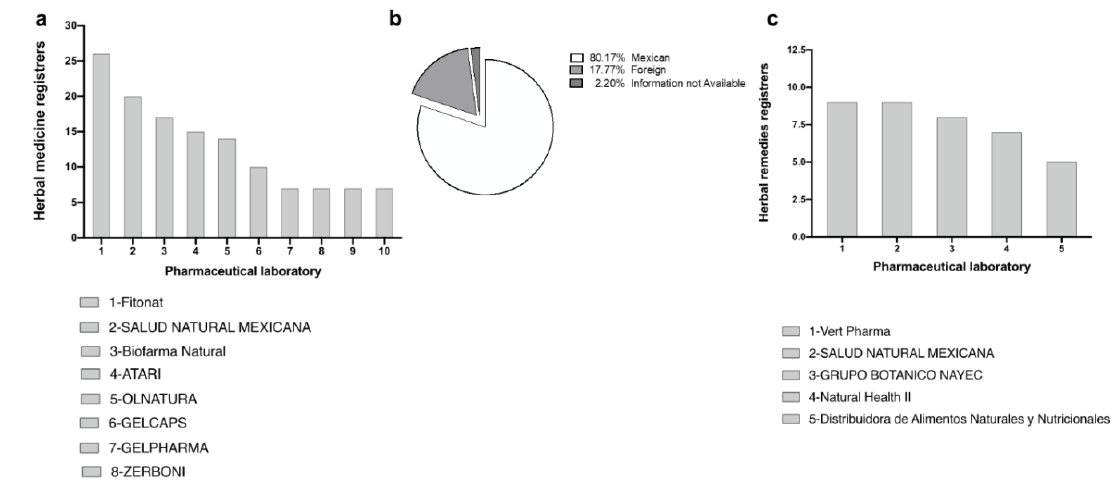
Figure 2. ( a ) The ten laboratories with the highest number of sanitary registries of herbal medicines in Mexico. ( b ) Origin of pharmaceutical laboratories with herbal remedies registers in Mexico. ( c ) The five laboratories with the highest number of sanitary registries of Herbal remedies in Mexico.